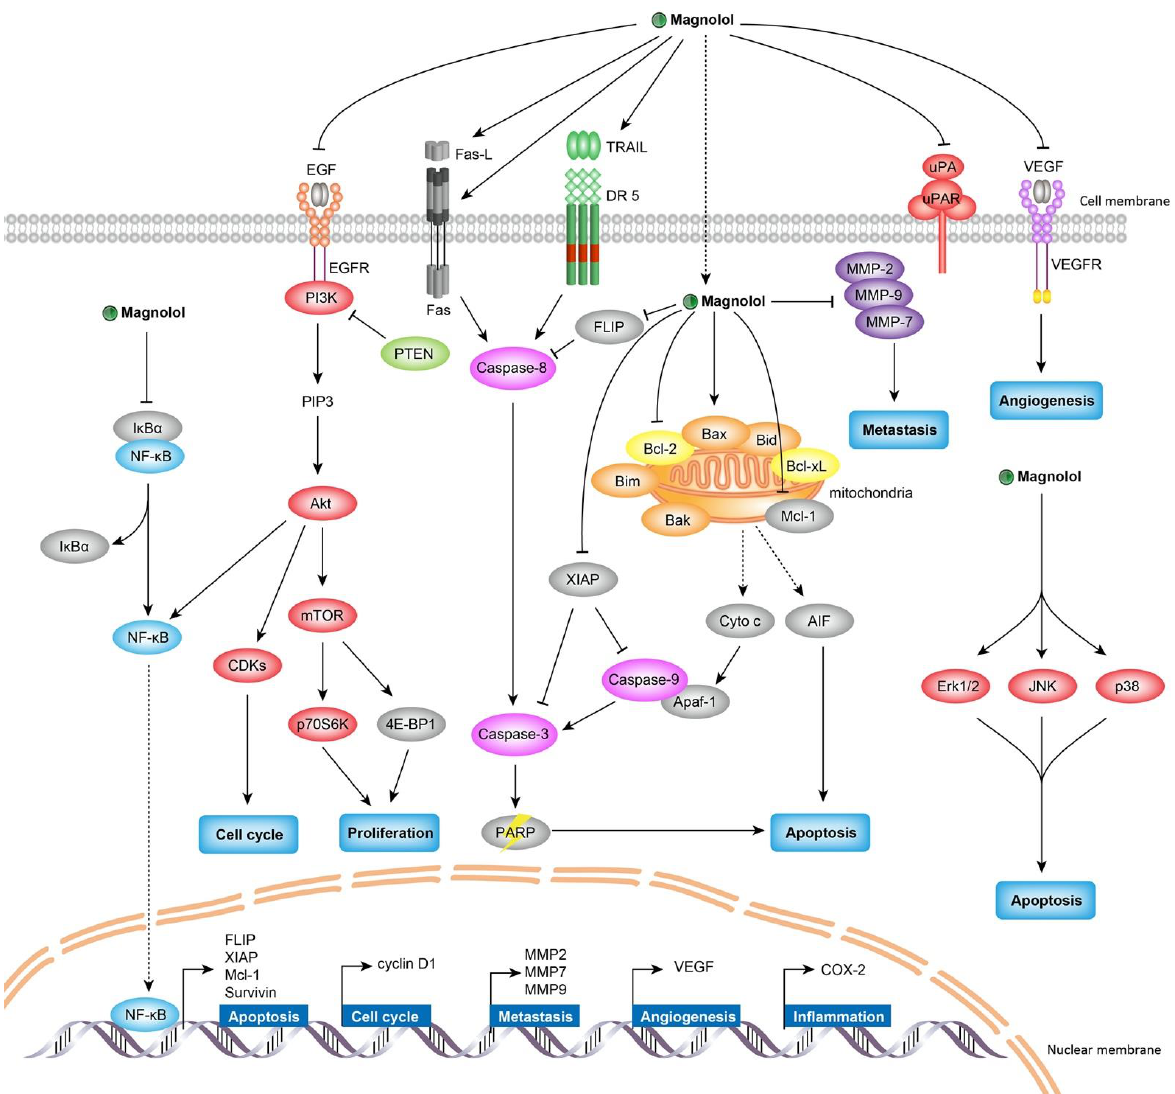
Figure 2. The anticancer mechanism of magnolol. Magnolol exerts anticancer effects through inhibiting proliferation, inducing cell cycle arrest, provoking apoptosis, restraining migration and invasion, and suppressing angiogenesis. Multiple signaling pathways are involved in the pharmacological actions of magnolol against cancer, such as PI3K/Akt/mTOR signaling, MAPK signaling, and NF- κB signaling. Table 1. The anticancer effect of magnolol against various cancer types.